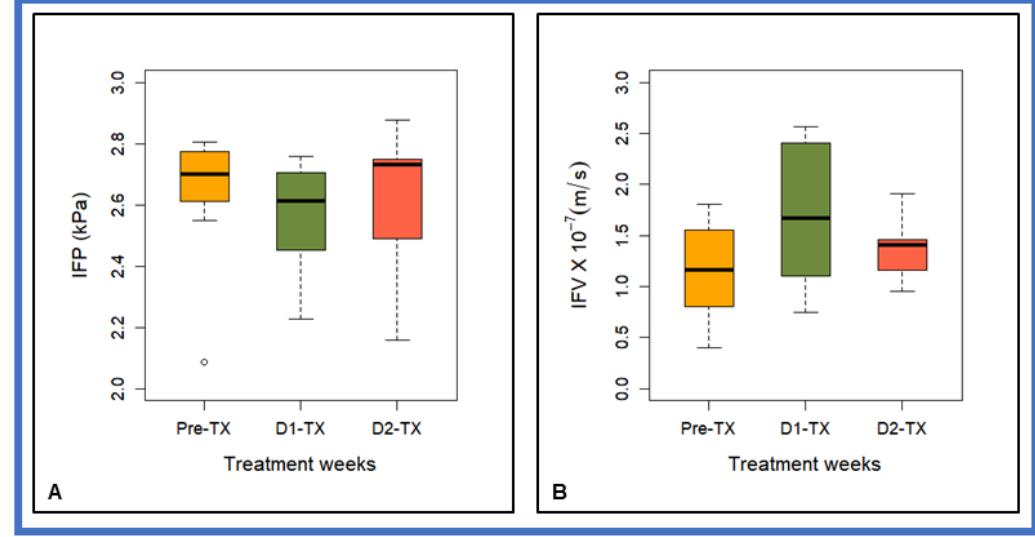
Figure 3. Box-and-whisker plot summarizing CFM estimates of ( A ) interstitial fluid pressure (IFP) and ( B ) interstitial fluid velocity (IFV) at pre-TX, D1-TX, and D2-TX in patients with PDAC treated with stereotactic body radiation therapy. The horizontal black lines in boxes represent the median, top, and bottom of boxes represent 25% and 75% percentiles of data values, respectively, and the open circle represents an outlier at pre-TX. Mean IFV values between the D1-TX and pre-TX showed a borderline significant difference ( p = 0.08).